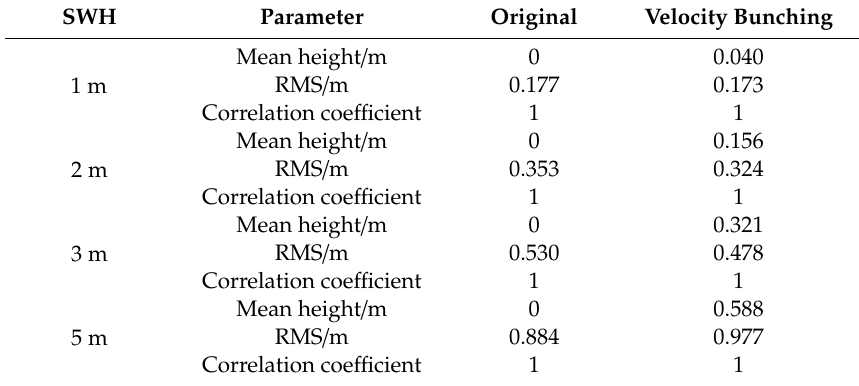
Table 3. The influence of velocity bunching under di ff erent SWH (the propagation direction is 90 ◦ , the wavelength is 200